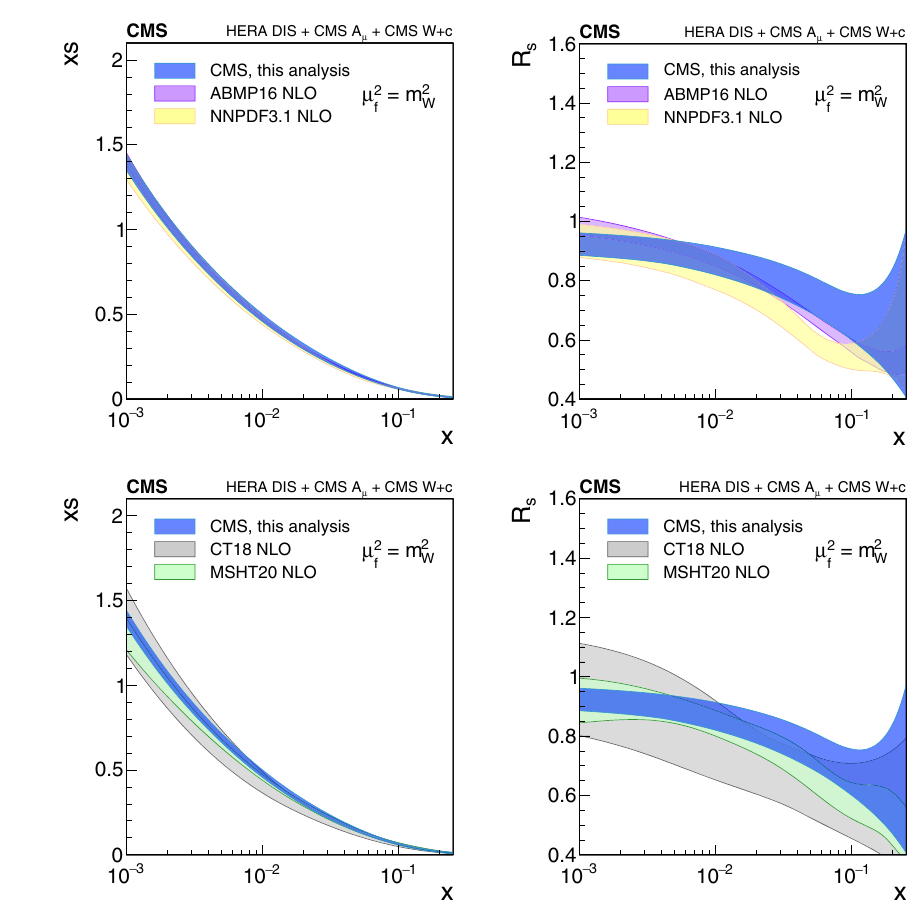
Fig. 8 The strange quark distribution (left) and the strangeness suppression factor (right) as a function of x at the factorization scale of m 2 . The W results of the current analysis are shown together with those from the global NLO PDFs, ABMP16 and NNPDF3.1 in the upper plot, and CT18 and MSHT20 in the lower one. This QCD analysis uses as input the combination of the inclusive deep inelastic scattering (DIS) cross sections [71], the CMS measurements of the lepton charge asymmetry in W boson √ s = 7 and 8TeV production at [72,73], and the CMS measurements of W + c √ s = 7 [5], 8 production at (this analysis) and 13TeV